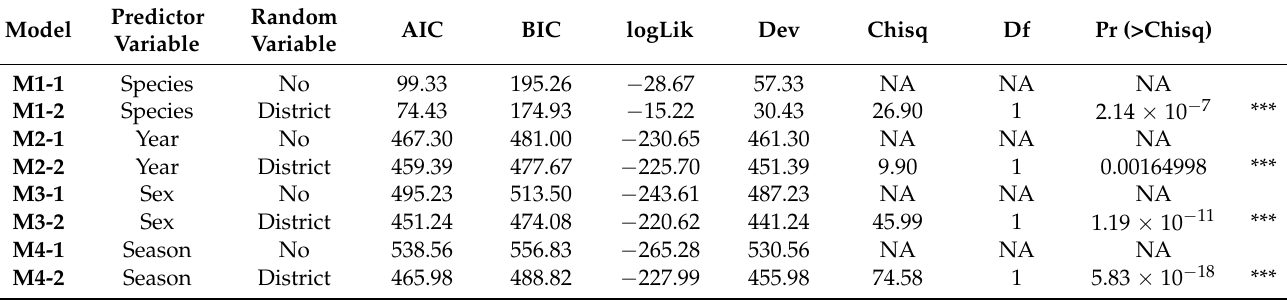
Table 4. LMM to test the correlation between each predictor with Spiroplasma infection using district as the random effect variable. Model